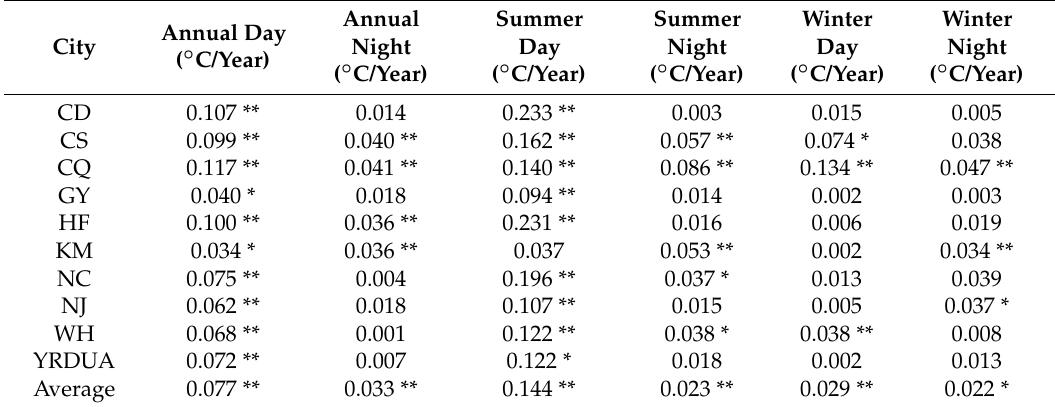
Table 7. Temporal trends of SUHII at 10 cities in YRB, China.